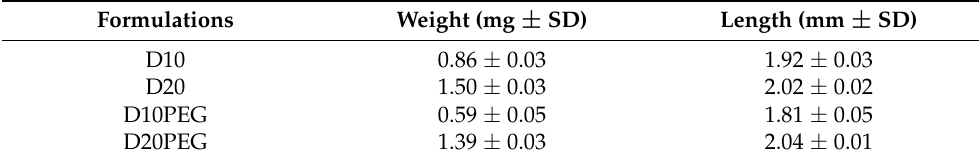
Figure 3. Light microscope images of the DLP 3D printed ( a ) D10, ( b ) D10PEG, ( c ) D20, and ( d ) D20PEG punctal plugs. The scale bar is equivalent to 1 mm. Table 2. Weights and dimensions of different DLP 3D printed punctal